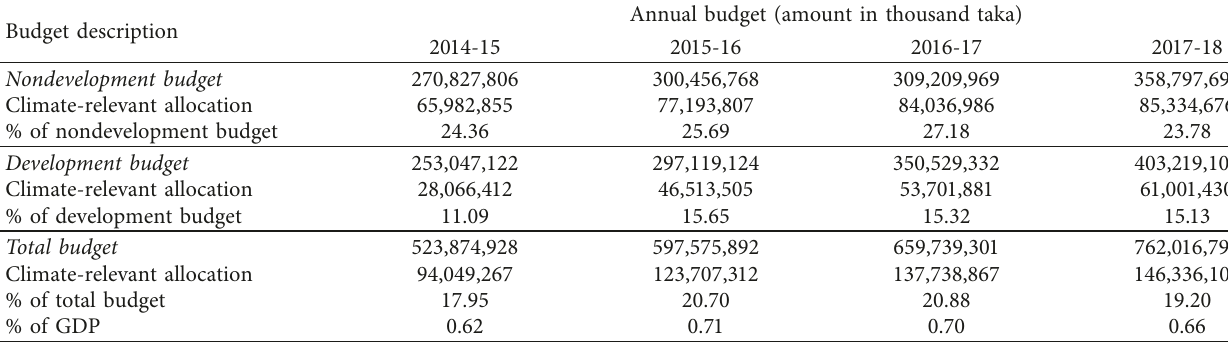
Table 1: Climate-relevant budget allocation in selected ministries from 2014 to 2018 [18].